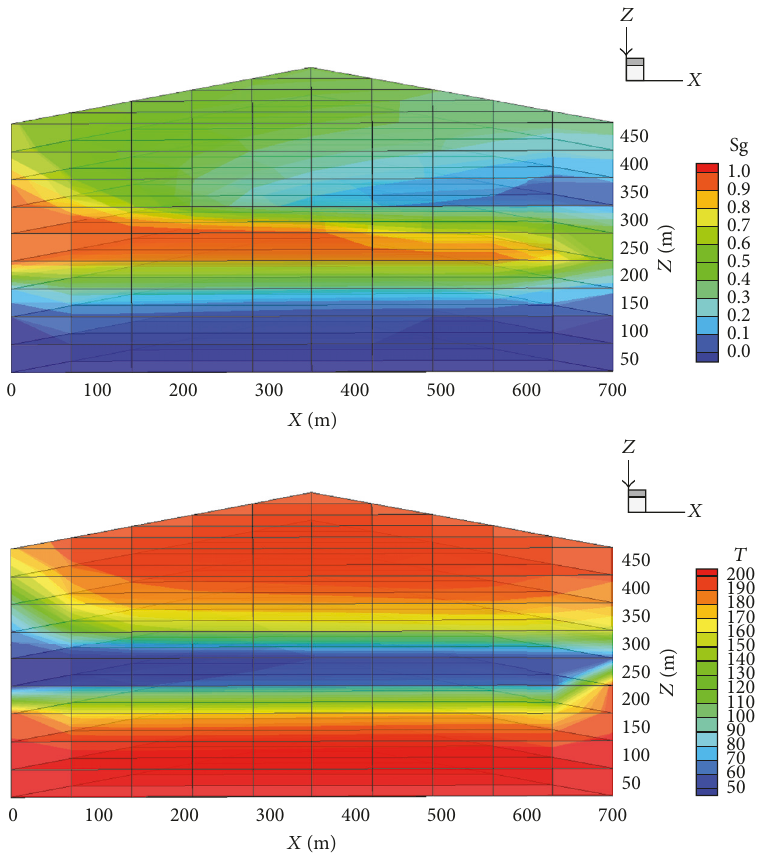
Figure 3: Simulated 3D profiles of gas saturation and temperature after 30-year injection of scCO 2 as a working